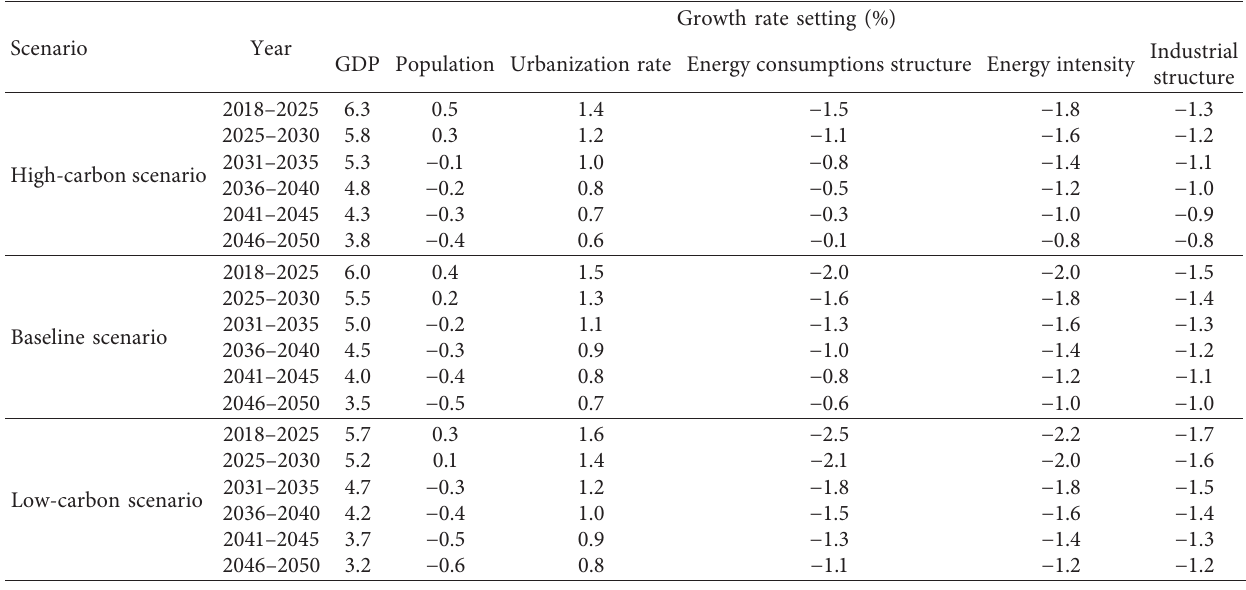
Table 5: Growth rates setting of carbon dioxide emissions’ influencing factors in the Chinese transportation industry.